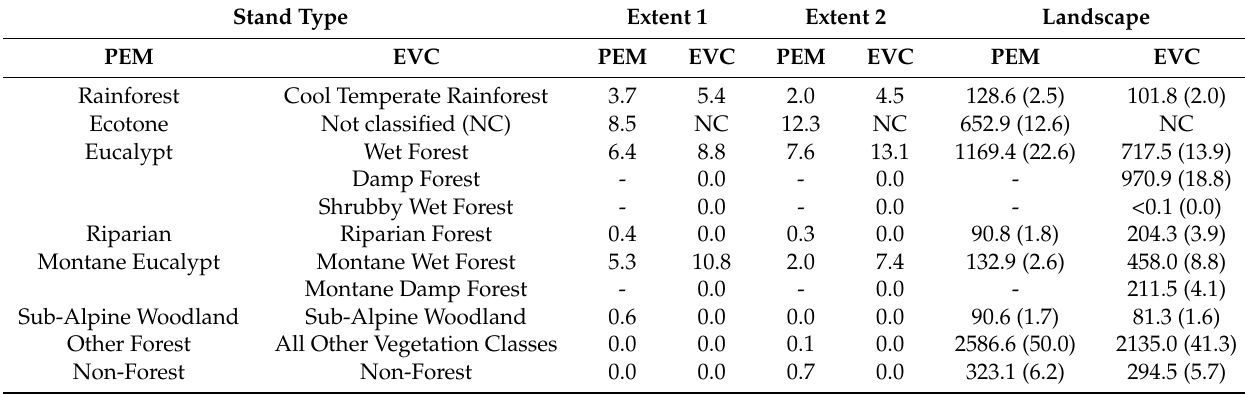
Table 5. Area of each stand type (km 2 ; percentage of total landscape in parenthesis) as predicted by the predictive ecosystem mapping (PEM) model compared with the ecological vegetation class (EVC) map. Values are for the entire study region (landscape) and two 5 km × 5 km extents (see Figure 1 for